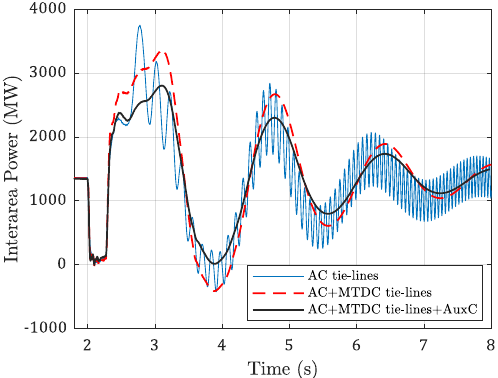
Figure 15. MTDC power where RP1 is rectifier 1 power, and ARP1 is rectifier 1 power with the auxiliary control.